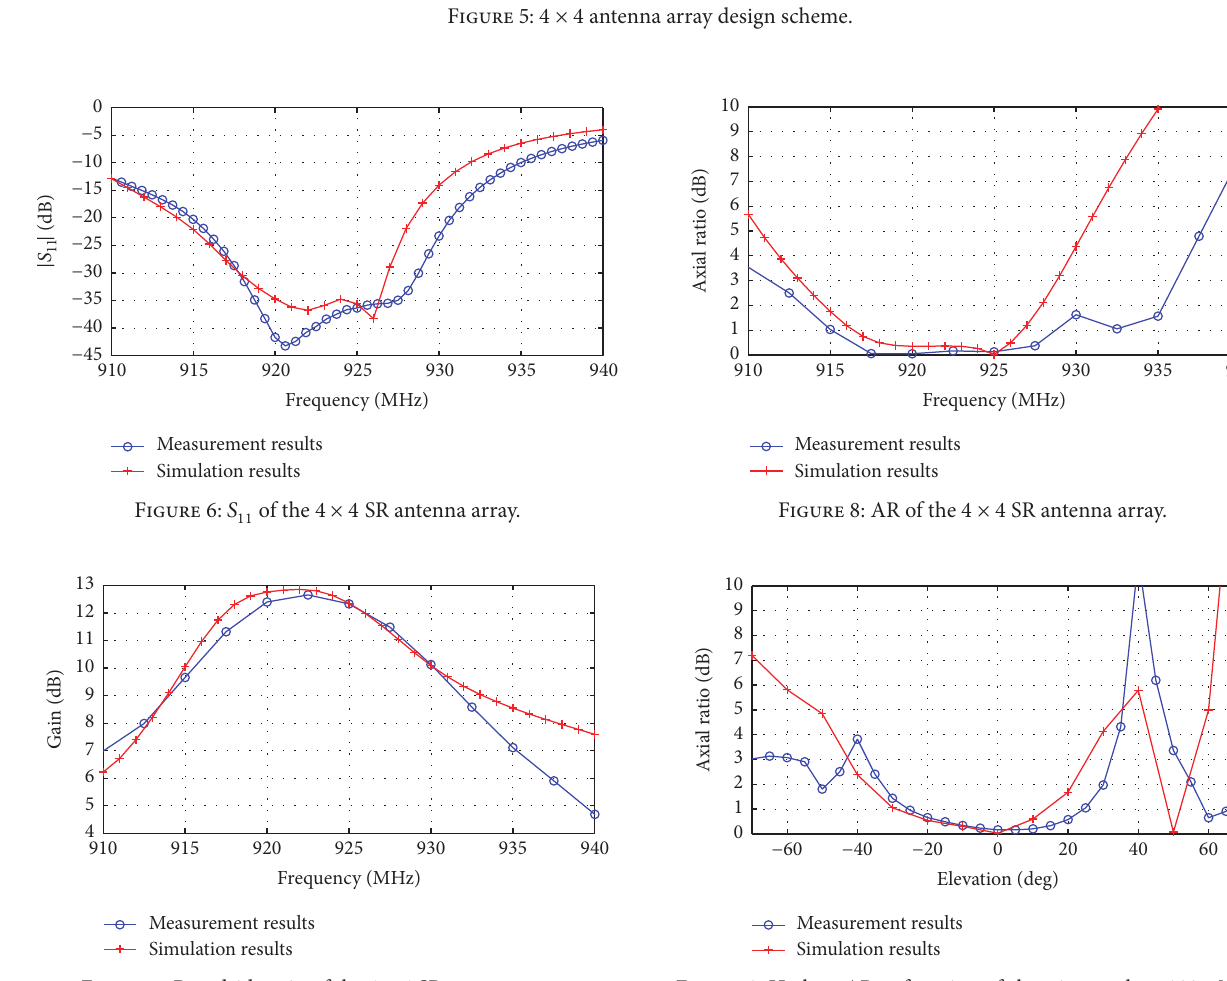
Figure 7: Broadside gain of the 4 × 4 SR antenna array.